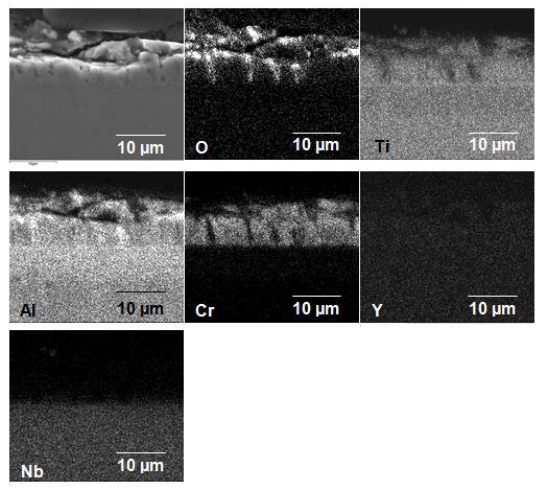
Figure 5. Digimaps of TiAlCrY coated Ti45Al8Nb after 500 hours oxidation at 750 ◦ C